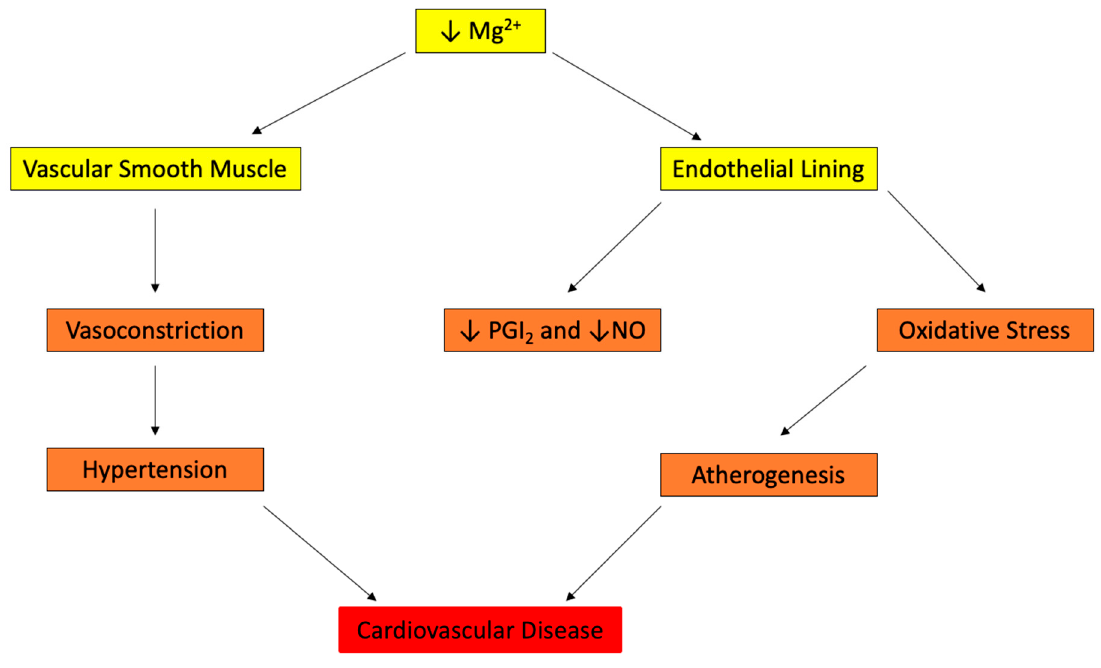
Figure 4. Cardiovascular implications of magnesium deficiency.